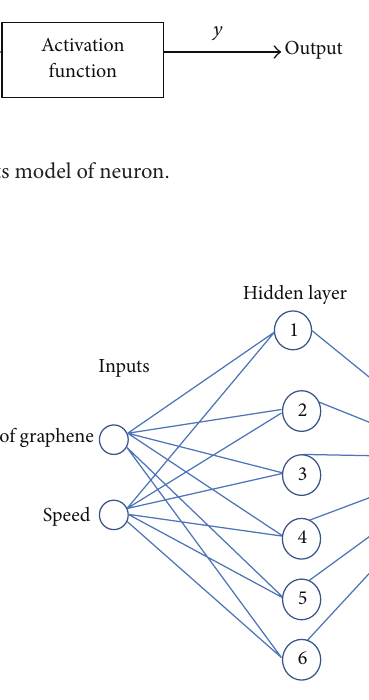
Figure 2: ANN architecture (prediction of required